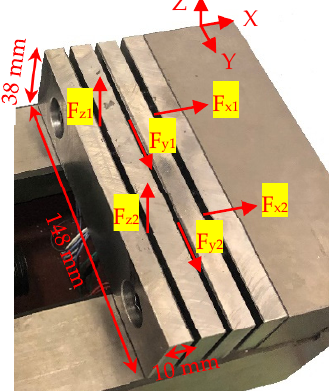
Figure 11. Jaw design with built-in piezoelectric sensors.